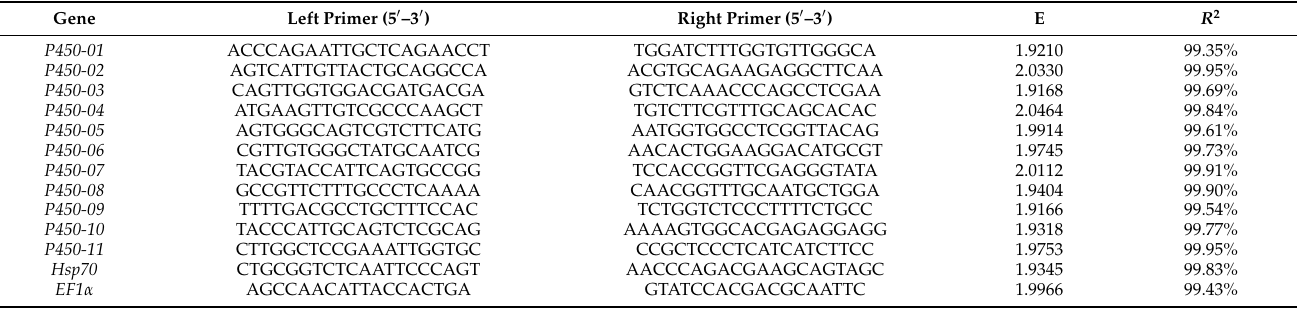
Table 1. Primers used in qRT-PCR. Gene Left Primer (5 (cid:48) –3 (cid:48) ) Right Primer (5 (cid:48) –3 (cid:48) ) E R